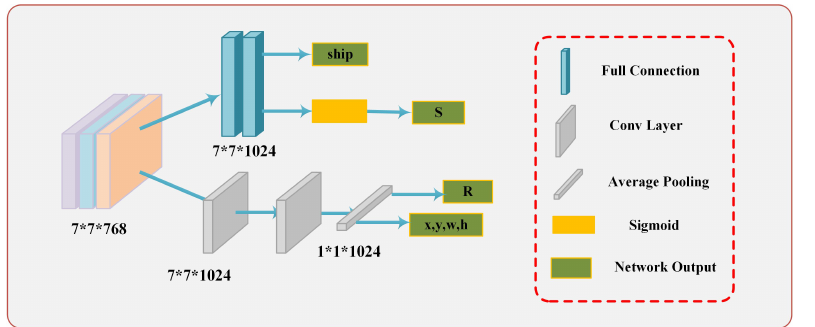
Figure 5. Illustration of the process of the ICR-head module. Each part is marked in the red box on the